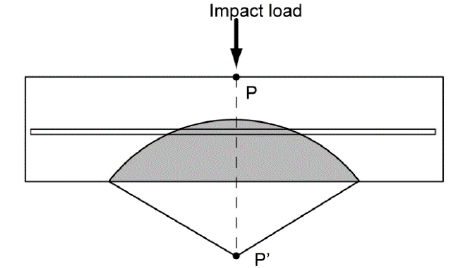
Figure 3. Scabbing theory [8].